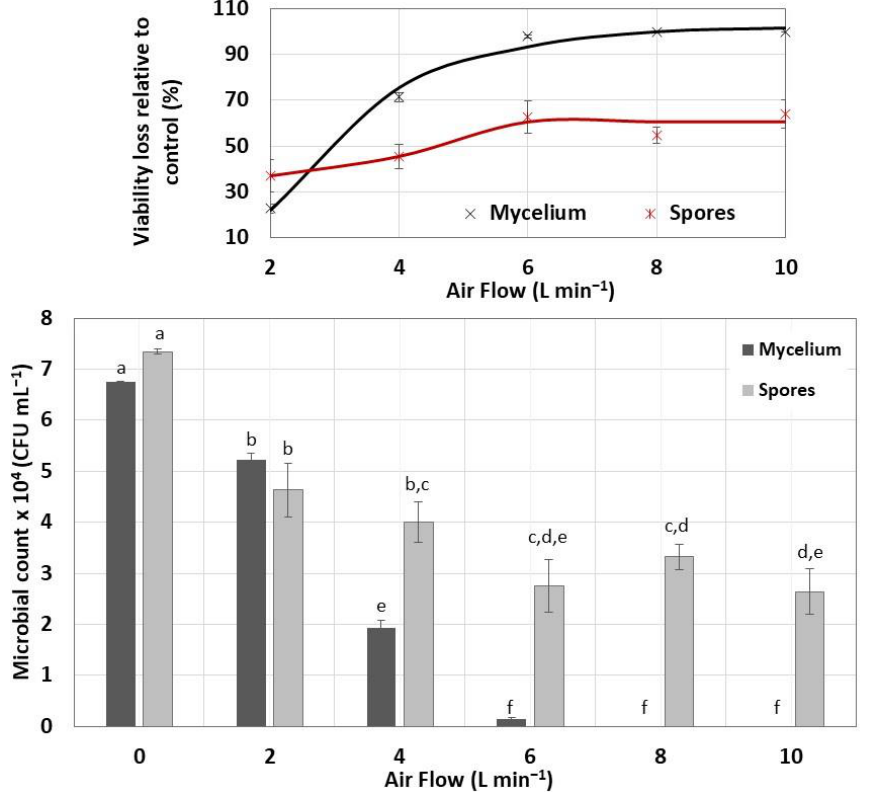
Figure 11. Effect of the airflow velocity on the viability of the immobilized biomass dehydrated in a rotary drum-type dryer. The mixed ANOVA indicated differences in the viability of Streptomyces CDBB1232 caused by the effect of the airflow and biomass type (significant effect of the airflow: F = 196.57, df = 5, p <0.001; mixed effect (airflow and biomass): F = 39.7, df = 5, p <0.001). Bars labeled with the same let ter do not significantly differ (Tukey’s test for an α = 0.05) .